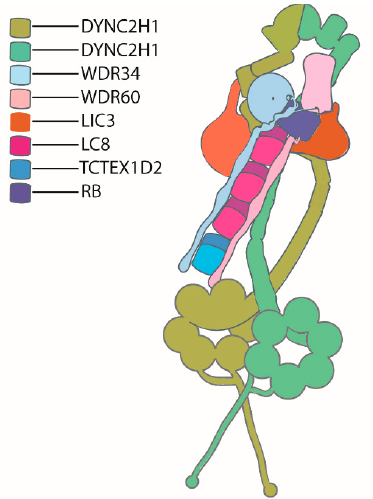
Figure 3. Sche matic of dynein-2, adapted from Toropova et al., 2019 [39]. Two copies of the dynein heavy chain form a homodimer, with one heavy chain adopting a zig-zag conformation at the tail region. One copy of the intermediate chain (DYNC2LI1 (LIC3)) is attached to each heavy chain. Two heterodimeric intermediate chains (WDR34 and WDR60) bind to DYNC2H1 via their C -terminal ends, and light chains are attached to the N -terminal ends of the intermediate chains.